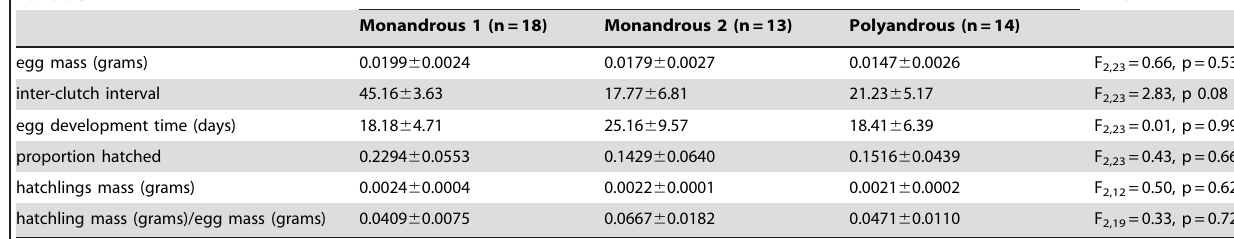
hatchling mass (grams)/egg mass